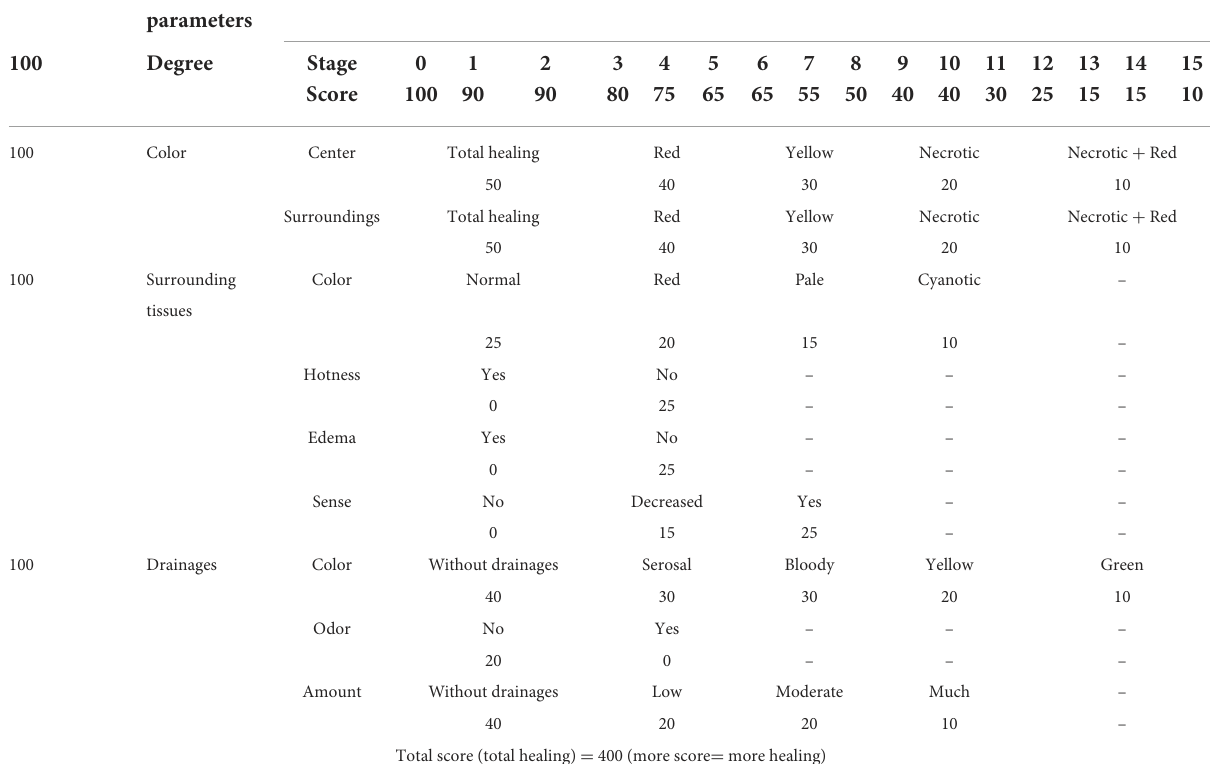
TABLE 1 Diabetic foot ulcer healing assessment